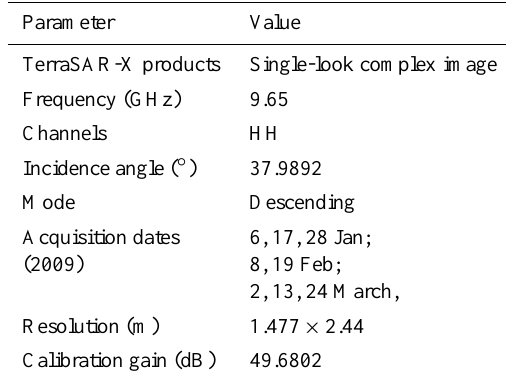
Table 1. TerraSAR-X acquisition